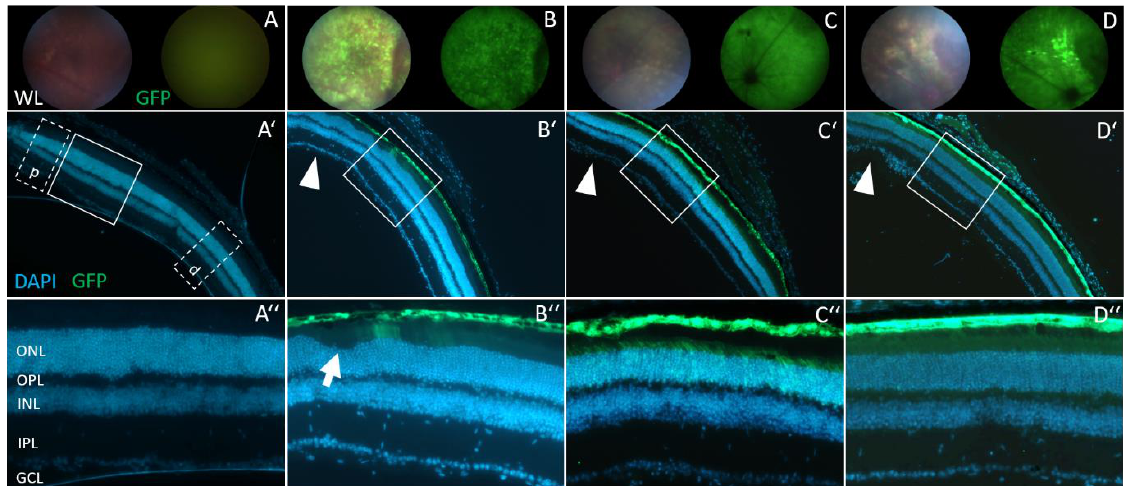
Figure 4. Fundus images and histological morphology of injected eyes. ( A-D ) Fundus images of injected eyes after white-light (WL, left) or UV-light with GFP channel detection (right). ( A ) PBS- and non-injected animals only showed background signal. ( B ) GFP fluorescence appeared across the wide areas of the fundus in mice injected with GFP-expressing AAV2/8. ( C ) Wild-type U1 and ( D ) engineered U1 four weeks after subretinal injection. Fundus pictures documented wide-spread GFP-expression and successful transduction of retinal cells. ( A‘ – D‘‘ ) Retinal cryosections document AAV2/8-mediated transductions mainly to the retinal pigment epithelium and photoreceptor layers. ONL thickness was measured at regions marked by boxes (dotted lines) and labelled by p and d in A’ . At and around the point of injection (arrowheads), mechanical damage to the retina can be detected (as in D‘ ). ( A‘‘ – D‘‘ ) Magnification of boxes showed that the overall retinal morphology was similar between eyes regardless of the injected construct. Retinal detachments (arrow in B‘‘ ) were observed occasionally. Panels A, C, D: Opa1 +/+ ; B: Opa1 enu/+ . WL, white light; ONL, outer nuclear layer; OPL, outer plexiform layer; INL, inner nuclear layer; IPL, inner plexiform layer; GCL, gan- glion cell layer. Table 1. ONL thickness of the central retina is not altered by the U1 treatments. The average outer nuclear layer (ONL) thickness in micro-meters (µm) is listed with standard deviations. Retinae from Opa1 +/+ (wild-type) and Opa1 enu/+ (heterozygous mutant) animals are compared. ONL thickness was measured at regions proximal and distal to the optic nerve head. Pairwise comparison of ONL thick- ness at proximal and distal regions between groups using Mann-Whitney U test with Bonferroni correction did not yield significant differences (Supplementary Table S2). The number of biological replicates is indicated in brackets (n = 5 – 16).